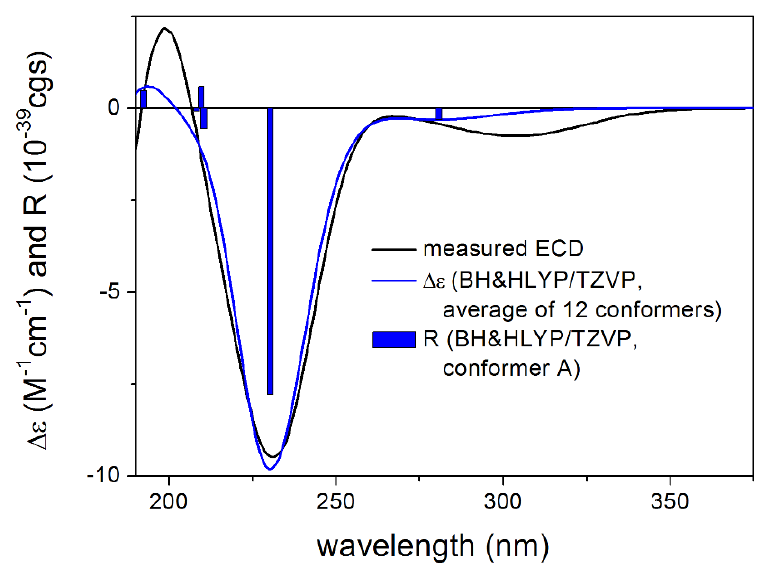
Figure 9. Comparison of the experimental ECD spectrum of 5 measured in MeCN with the BH&HLYP/TZVP PCM/MeCN spectrum of (4 R ,6 R ,7 S ,8 S ,9 R ,10 R ,11 S )- 5 (level of optimization: CAM-B3LYP/TZVP PCM/MeCN). The bars represent the rotational strength values of the lowest energy conformer.